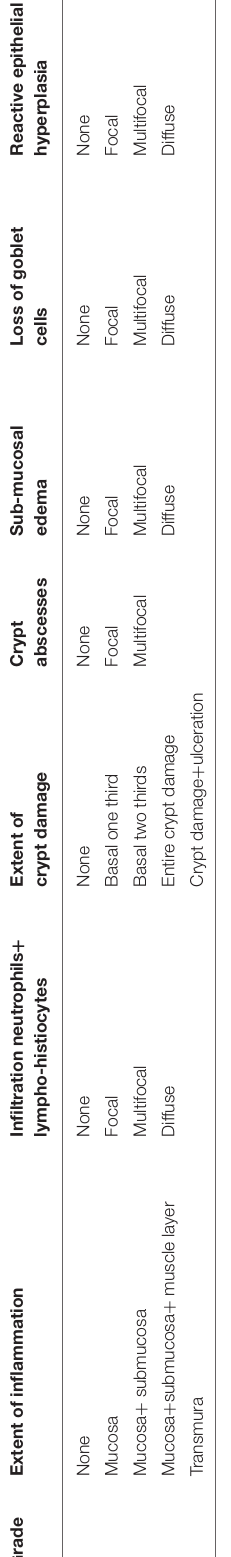
TABLE 4 | Primers used for real-time PCR analysis. Genes